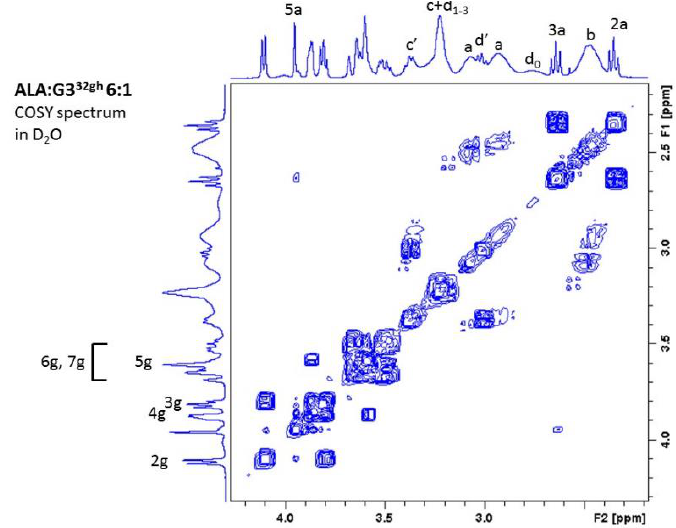
Figure A1. 1 H- 1 H- COSY spectrum of G3 32gh in D 2 O.